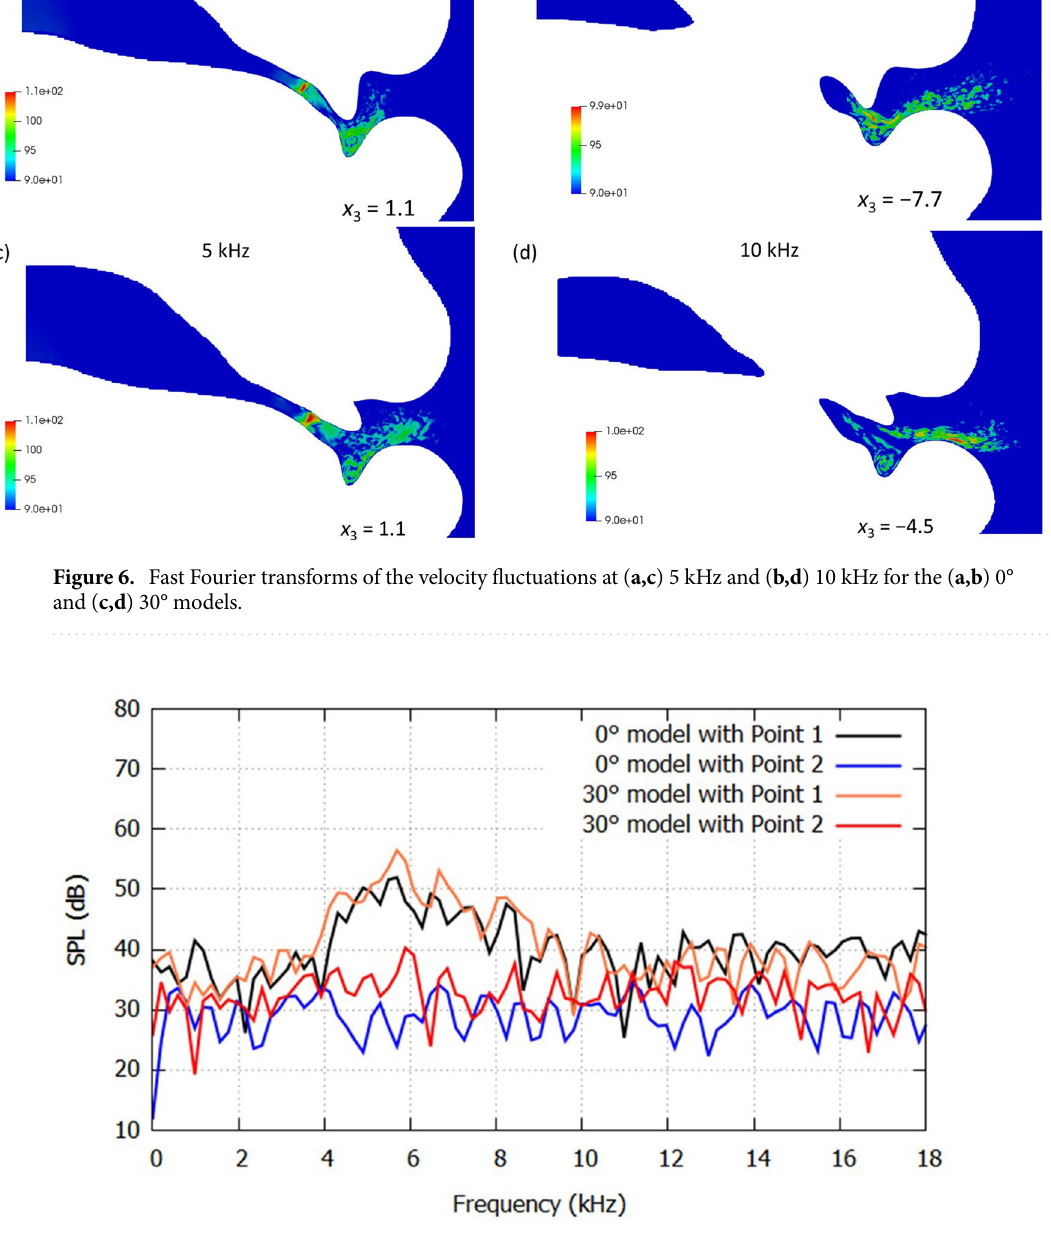
Figure 7. SPL spectra for the 0° and 30° models predicted for the monopole acoustic sources at Point 1 (0.049, − 0.0084, − 0.0077) and Point 2 (0.0585, − 0.0077, −